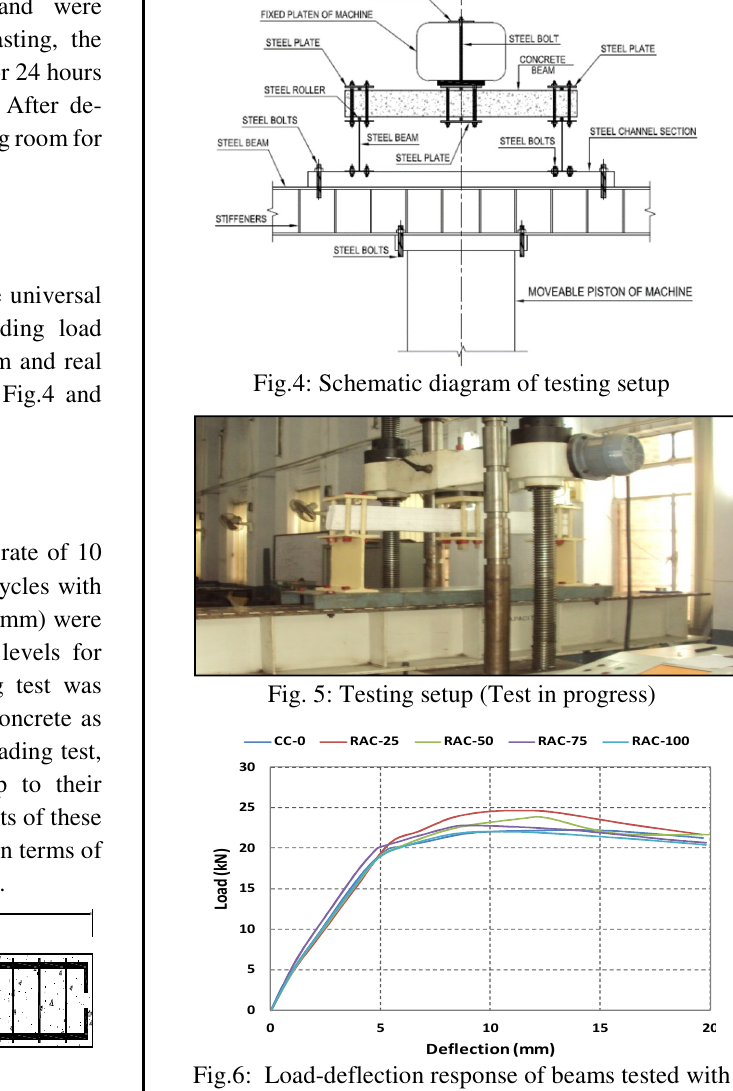
Fig.6: Load-deflection response of beams tested with monotonic